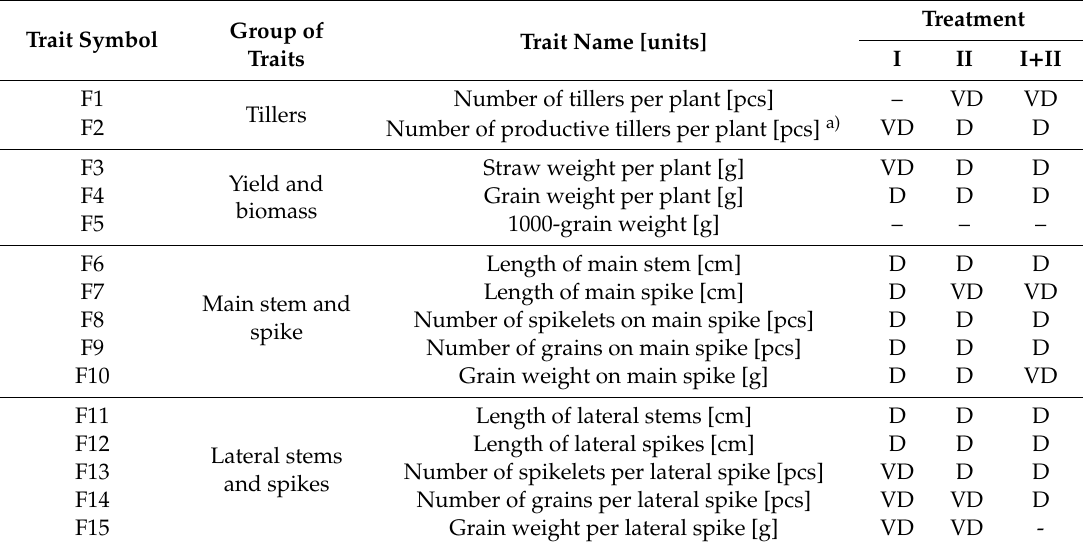
Table 2. Phenotypic traits of barley plants measured at maturity. Symbols D and VD indicate type of reaction of the trait to drought: D—mean drought e ff ect; VD—variety-specific drought e ff ect (ANOVA F-test, p <